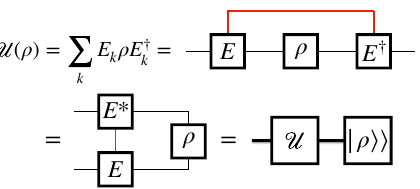
FIG. 2. The tensor representation of a quantum channel in (cid:2) . The contraction of index k its operator-sum form E k ρ E † k k (red line) corresponds to the summation of E k . We group the two indices of ρ to form a vector | ρ (cid:5)(cid:5) , then we obtain the superoperator form of U